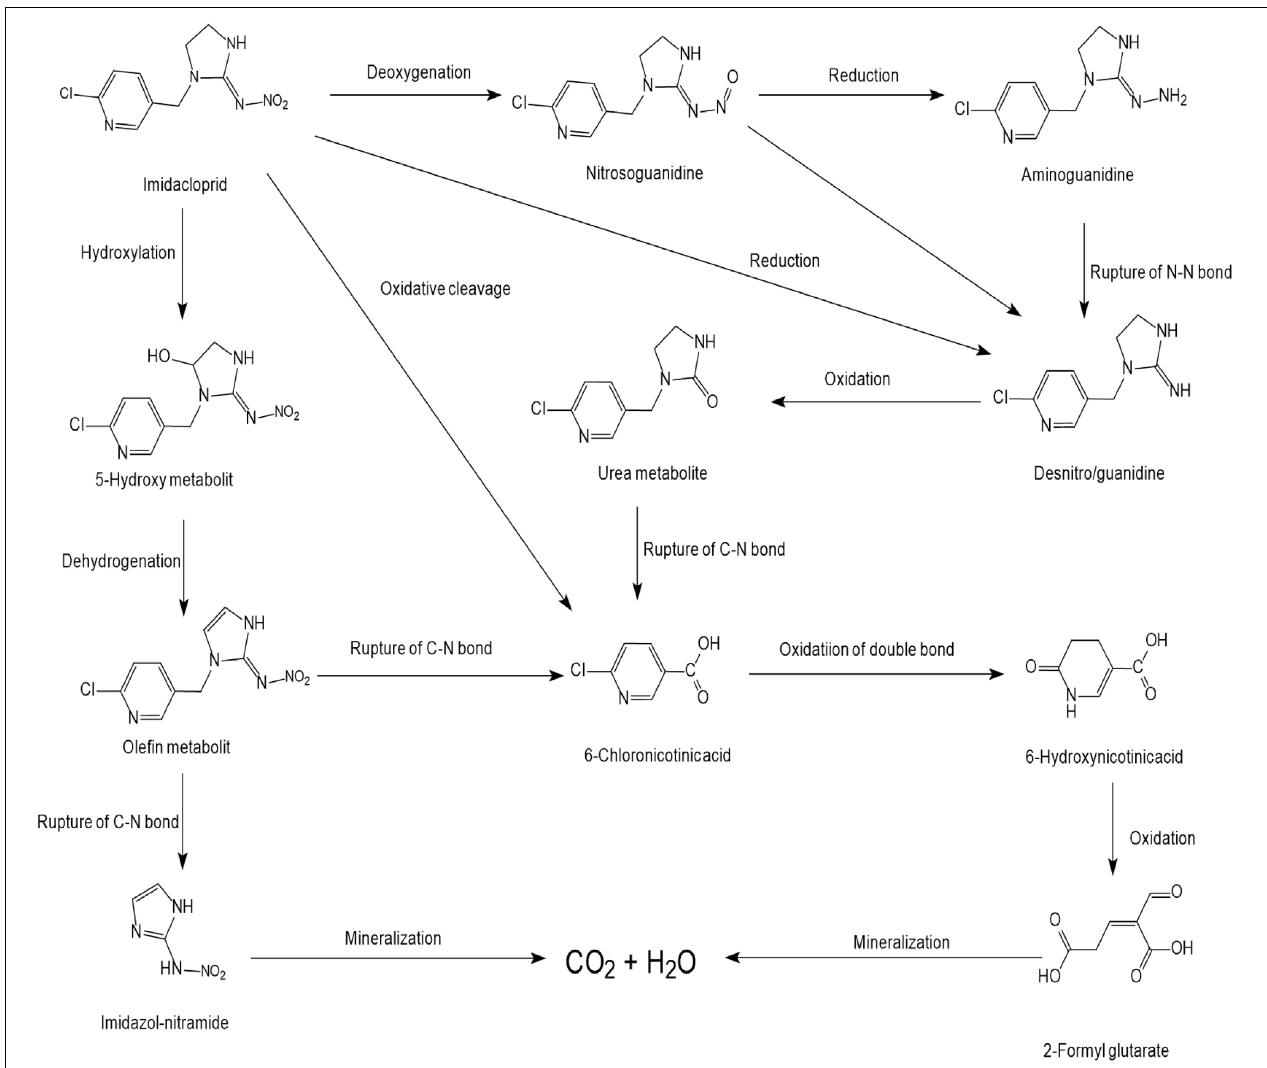
FIGURE 1 | Microbial degradation pathways of imidacloprid (based on Akoijam and Singh, 2014; Sharma et al., 2014; Sabourmoghaddam et al., 2015).